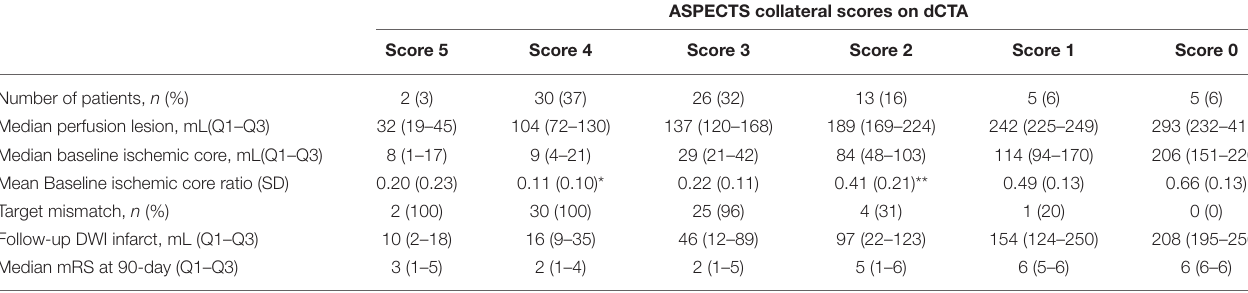
TABLE 3 | Patient clinical and imaging characteristics grouped by ASPECTS collateral scores.